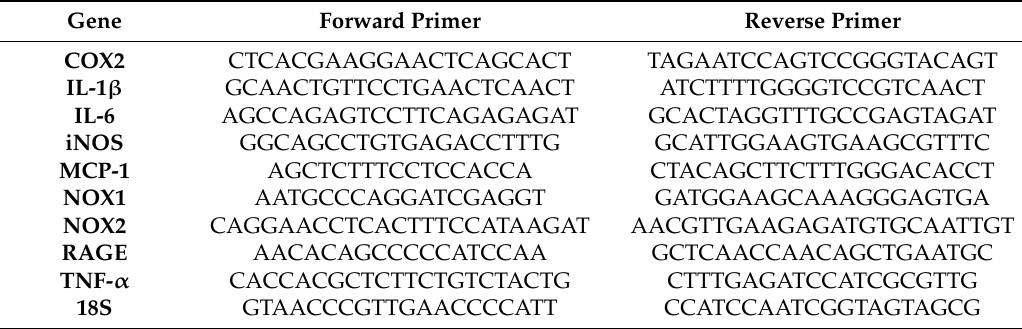
Table A1. Primers used for QPCR